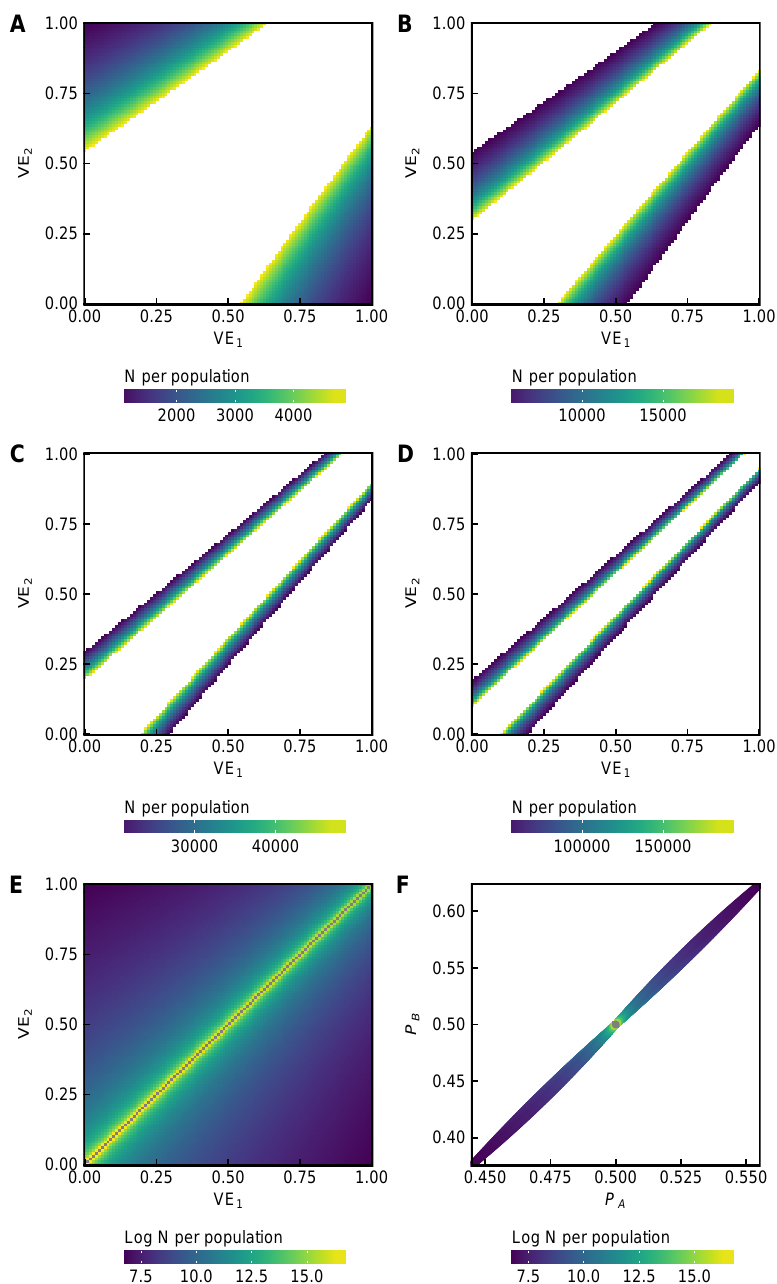
Figure A12. Given differences in vaccine effectiveness against strain 1 and strain 2 (Figure A11), we estimate the sample sizes per population required to achieve 0.90 statistical power to detect the corresponding difference in strain frequencies between populations A (20% vaccine coverage) and B (40% vaccine coverage) at 0.05 significance, assuming equal distribution of sample sizes over time. Required sample sizes are divided into several ranges for visual clarity in ( A – D ), and are shown on a log scale in ( E ). The required sample size to detect a difference in the proportion of strain 1 in population A versus population B (which is determined by the difference in VE against strain 1 and 2) is shown on a log scale in ( F ). Also in ( F ), the white space is outside the range of Equation (A23) when VE is between 0 and